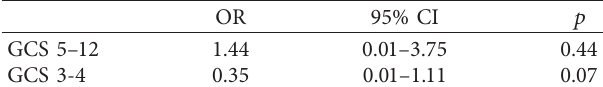
Table 5: Risk of 30-day mortality based on the Glasgow Coma Scale score with regard to the day of admission versus GCS 13–15 (weekdays vs